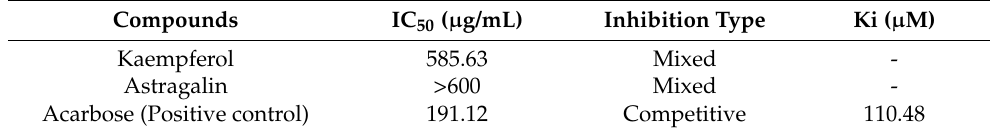
Table 3. Alpha-glucosidase inhibitory activity of selected flavonoid compounds.